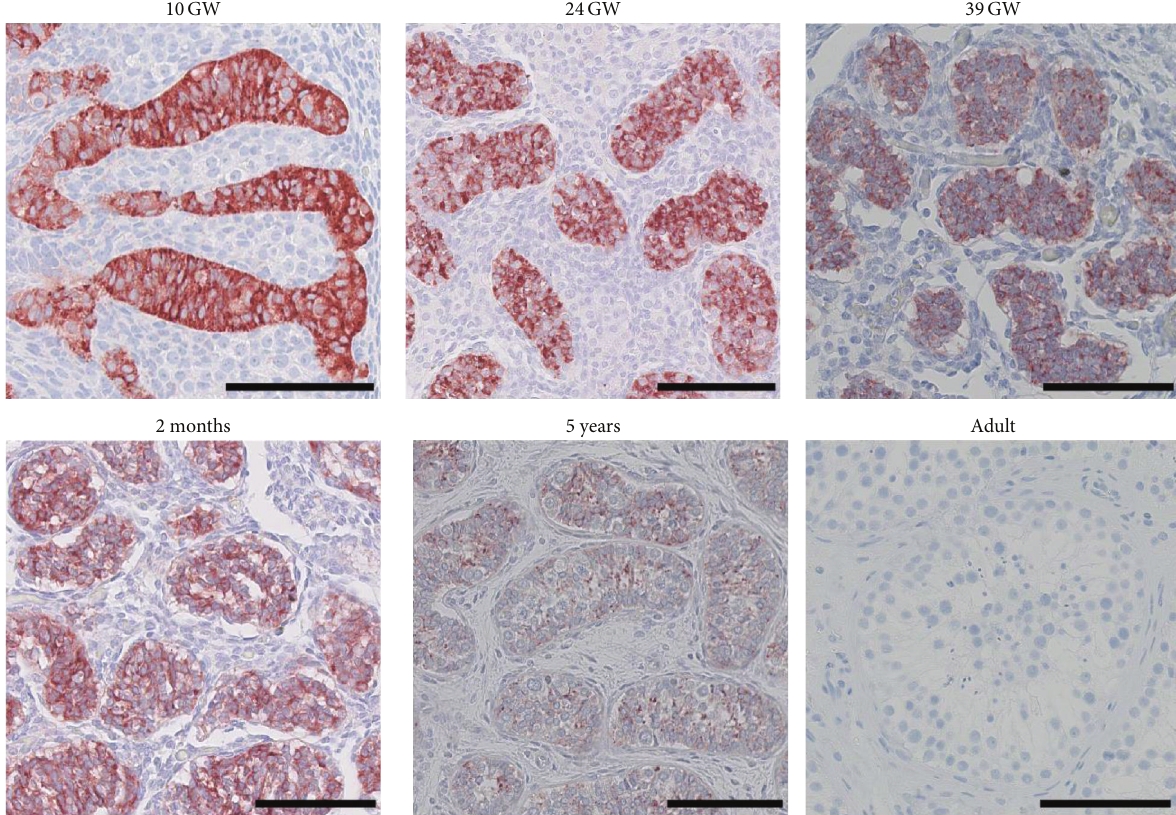
Figure 3: Immunohistochemical staining of AMH in testis tissue. GW: gestational week. Scale bar corresponds to 100 𝜇